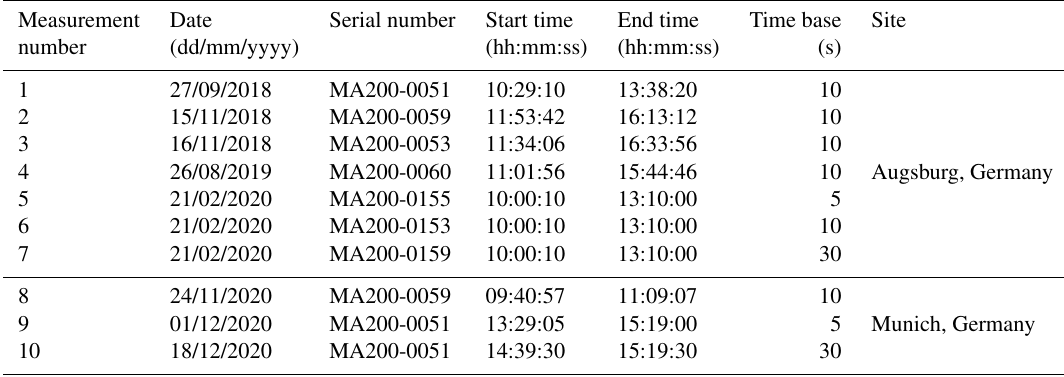
Table 1. Measurements of black carbon by different MA200 devices.